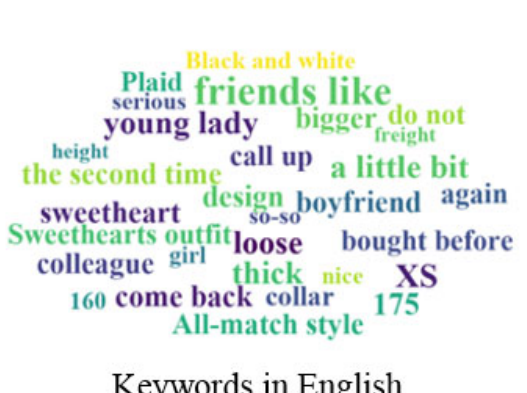
Figure 4. The most different words under different product consideration (6 products).